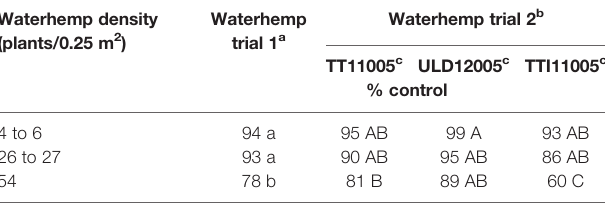
TABLE 7 | Waterhemp control 21 DAT as in fl uenced by grass density and nozzle type. Waterhemp density (plants/0.25 m 2